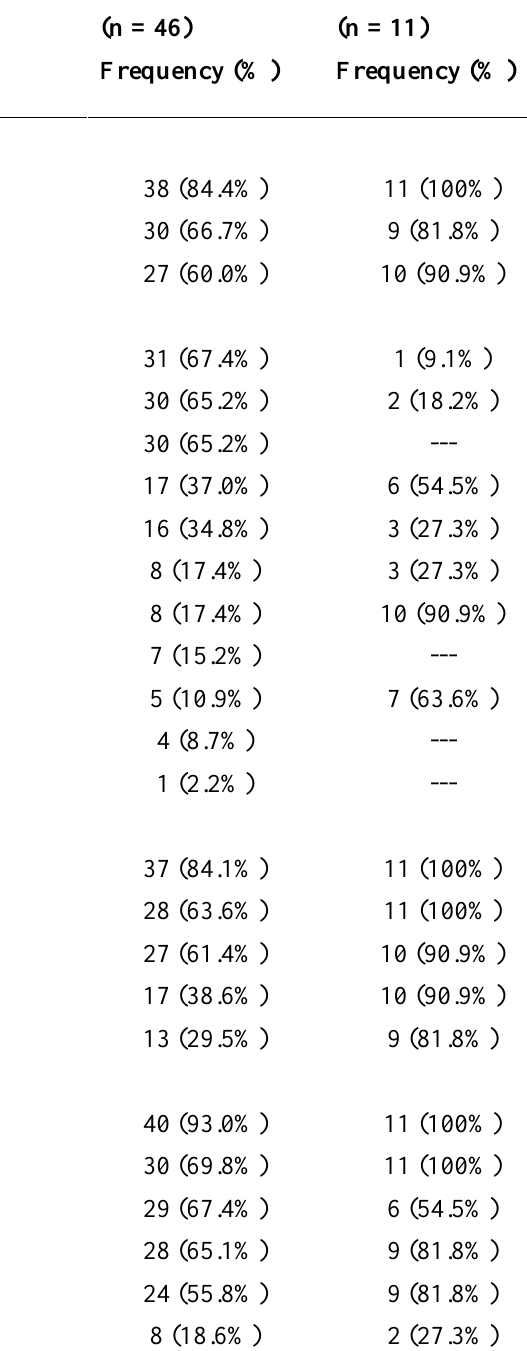
Table 5. Frequencies of selected characteristics from the quantitative survey instrument.